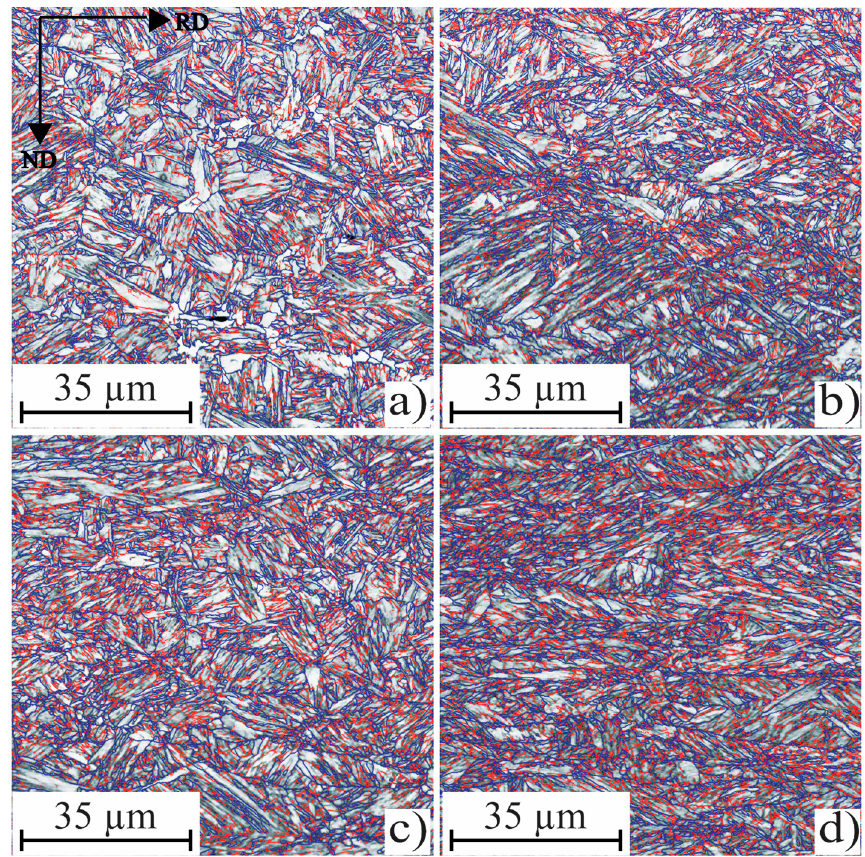
Figure 6. ECD effective high-angle grain sizes at different percentiles in the cumulative grain area distribution of the investigated steels after direct quenching for an FRT of 900 °C.